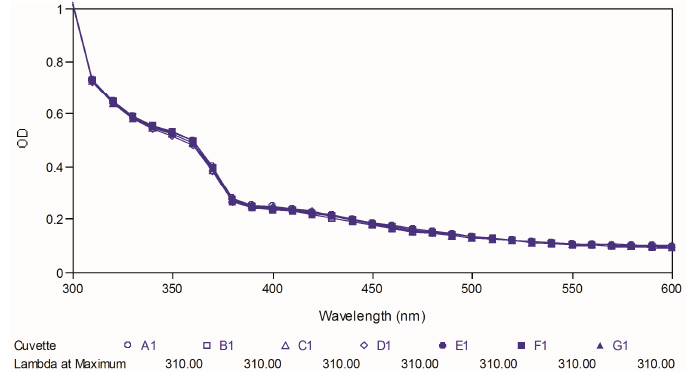
Figure 9. Ultraviolet-visible absorption spectra of compound 88 .